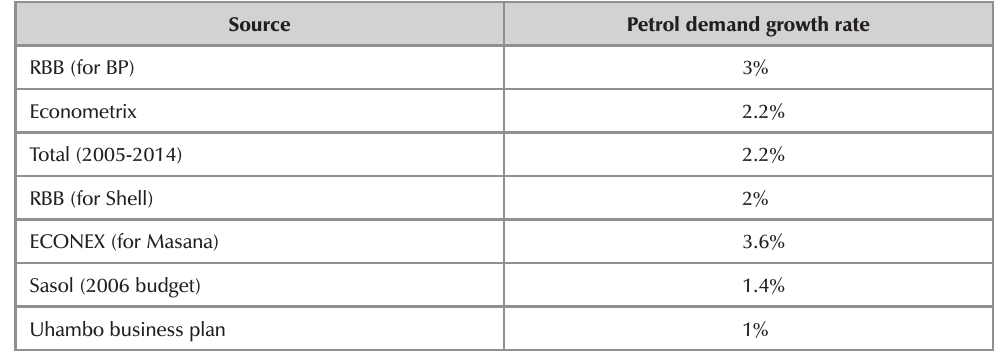
Various estimates of petrol demand growth